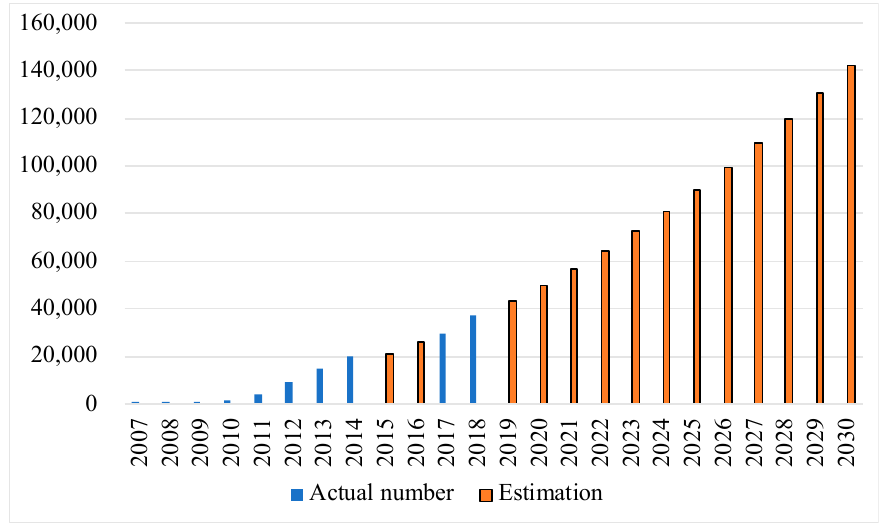
Figure 6. Actual number and estimation of secondhand HV exportation from Japan to Mongolia. Source: Figure made by the author based on the data from Nippon Steel and Trade Statistic of Japan [7,23]. Note: R2 of the approximate curve is 0.9807.